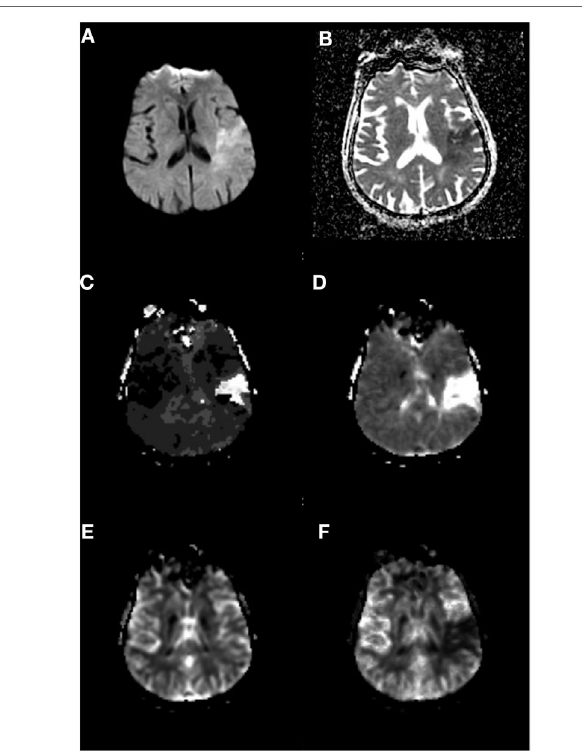
FigURe 4 | CT perfusion (CTP) cerebral blood flow (CBF) maps do not correspond with infarct core. Eighty-four-year-old male with left middle cerebral artery (MCA) stroke with dense distal M2 occlusion presenting with initial National Institutes of Health Stroke Scale (NIHSS) of 9. By the time of the admission, NIHSS was 2 and patient did not receive IV tPA or endovascular treatment. The CTA/ CT perfusion (CTP) was acquired at 4.9 h from last-known well (LKW), magnetic resonance imaging was performed 19 min after the CTP. (A) CBF, (B) diffusion-weighted imaging (DWI) performed 19 min after CTP, (C) CTA shows occlusion of MCA superior division segment, (D) DWI with acute infarct mapped in red, (e) CT head at 24 h from LKW, and (F) follow-up FLAIR image at 34 days post-stroke depicting final infarct. Note the CTP CBF hypoperfused region identified as 30% of mean contralateral hemisphere is much larger than that of the DWI scan, and corresponded better with tissue infarction on follow-up. Courtesy of William A. Copen, MD, Department of Radiology, Massachusetts General Hospital. Data analysis for figure was created under approval of local ethics committee.